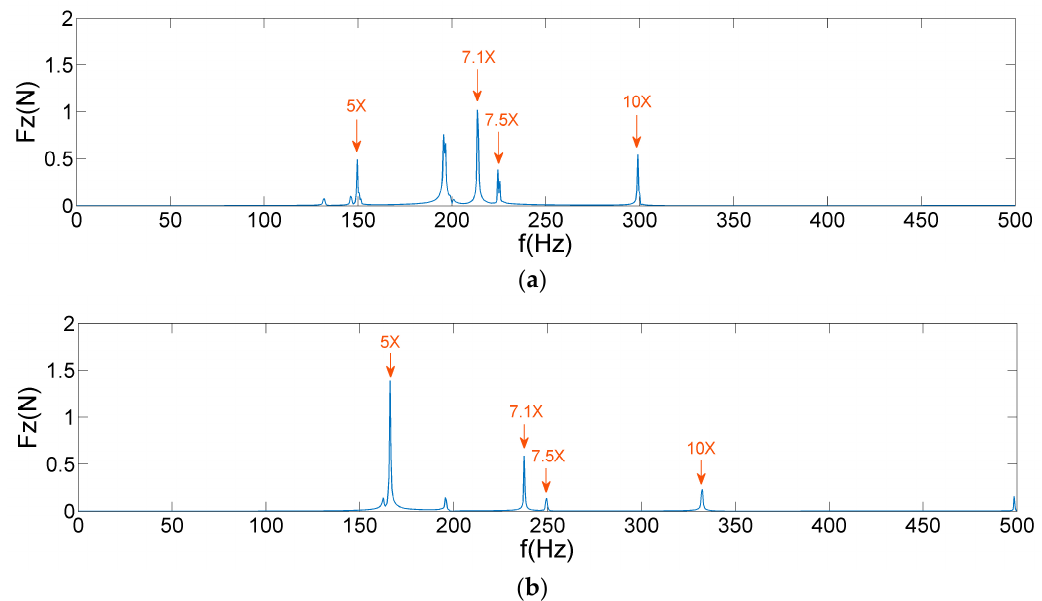
Figure 16. AIC–SVD denoised frequency spectra of F z : ( a ) 1800 rpm; ( b ) 2000 rpm.